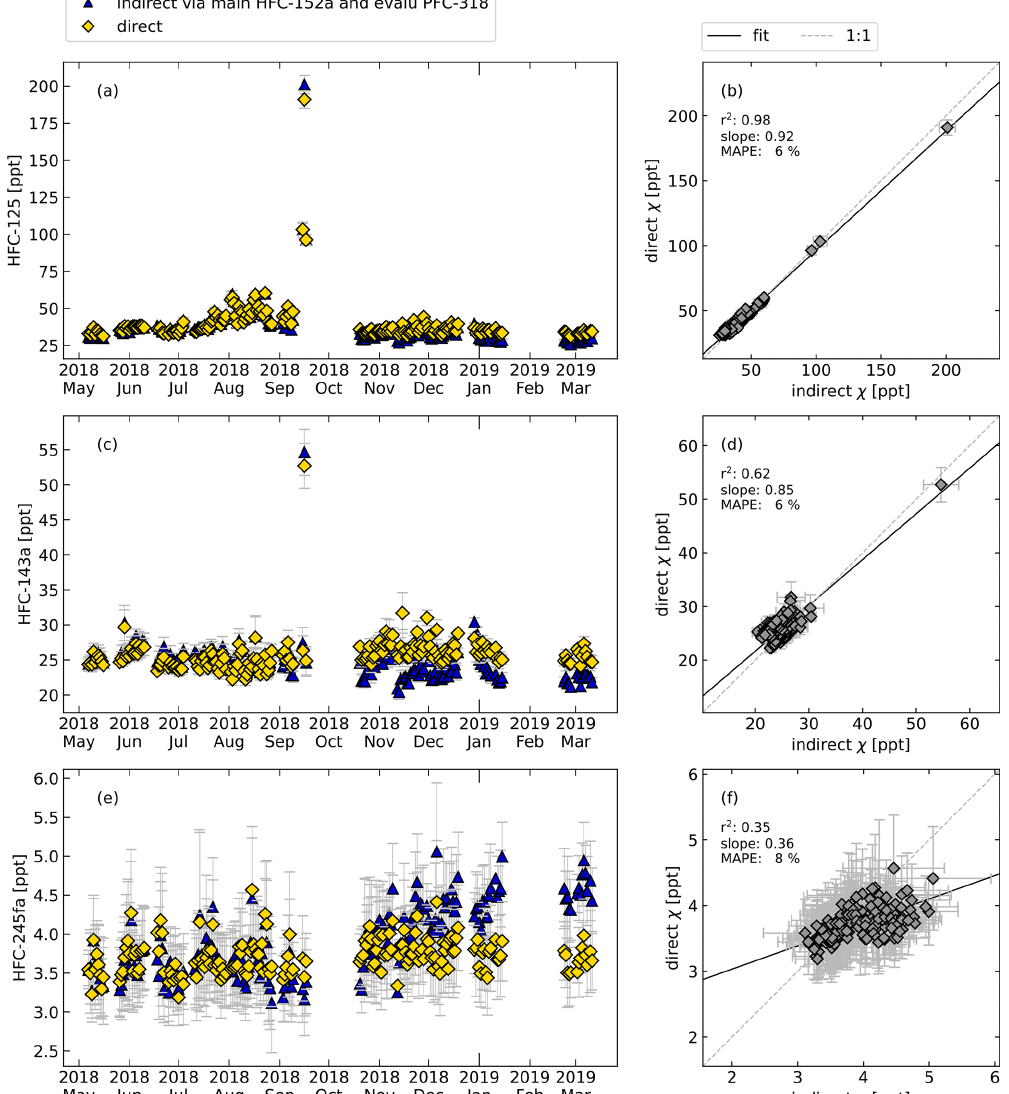
Figure 8. Same as Fig. 6 but for the continuous in situ measurements at Taunus Observatory using GC–MS and for the following compounds: HFC-125, HFC-143a, and HFC-245fa, calculated directly (yellow symbols) and indirectly (blue symbols). Here, HFC-152a was used as main reference substance and PFC-318 as evaluation substance to select data with constant rRF. For reasons of simplified illustration, daily means are shown. The error bars indicate the standard deviations of the measurements of 1d and thus reflect the daily atmospheric variability and do not include systematic errors due to the indirect calibration